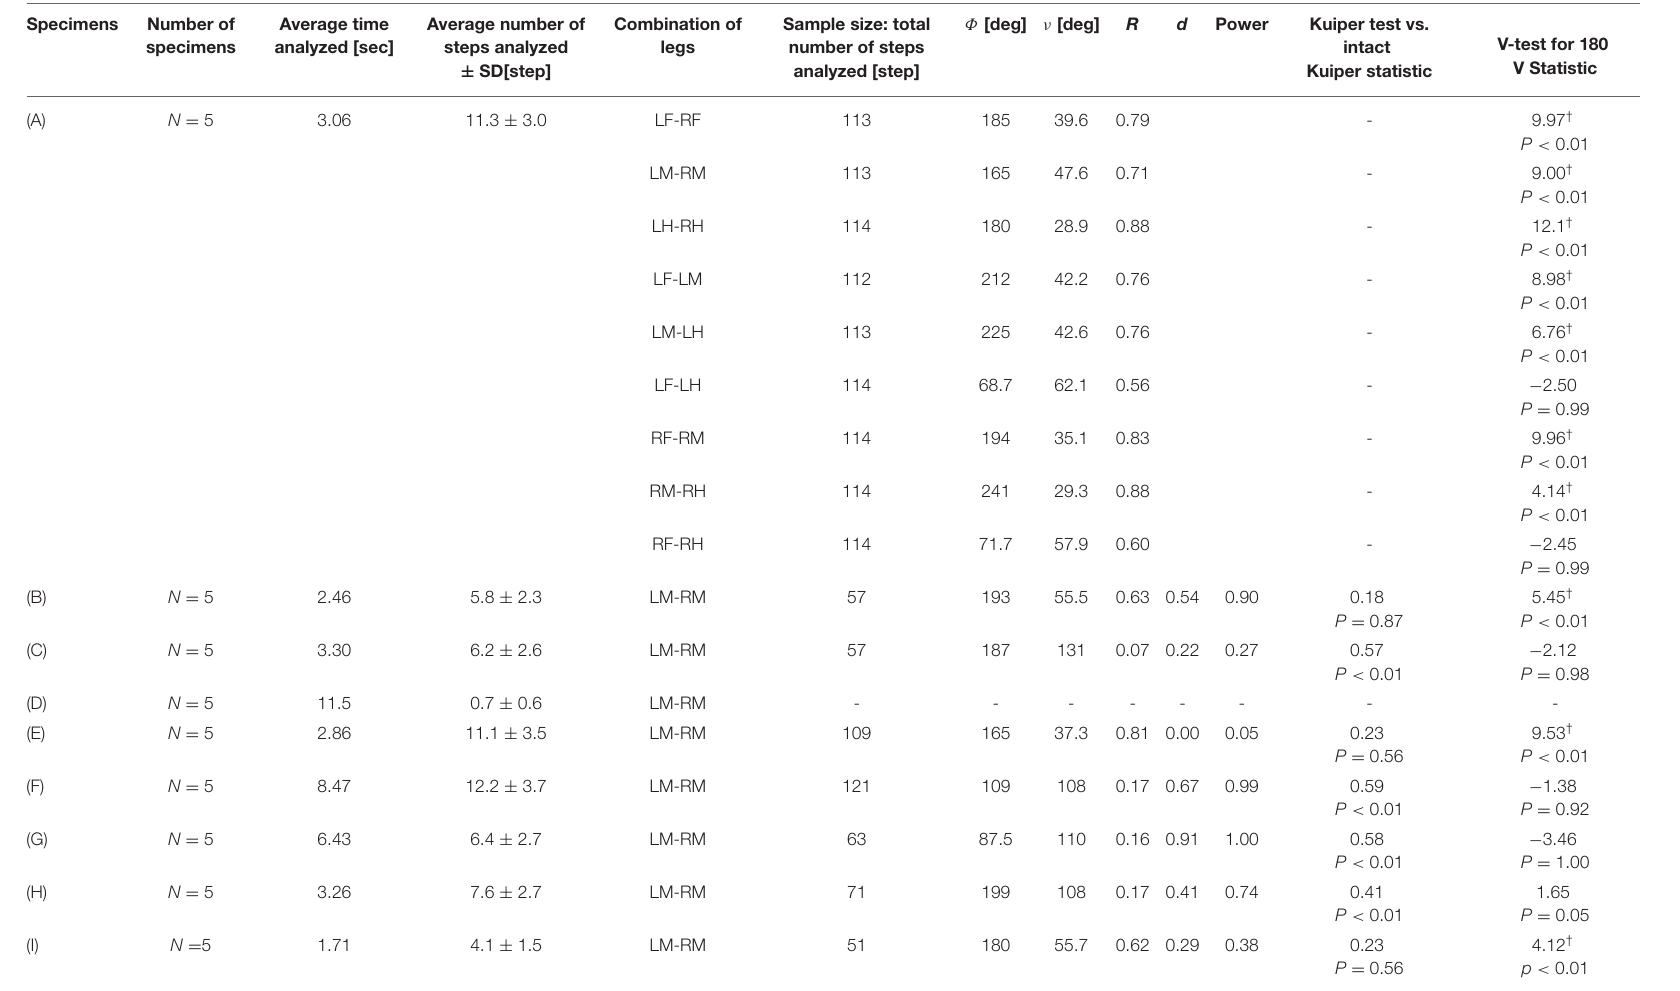
TABLE 1 | Summary of the results.